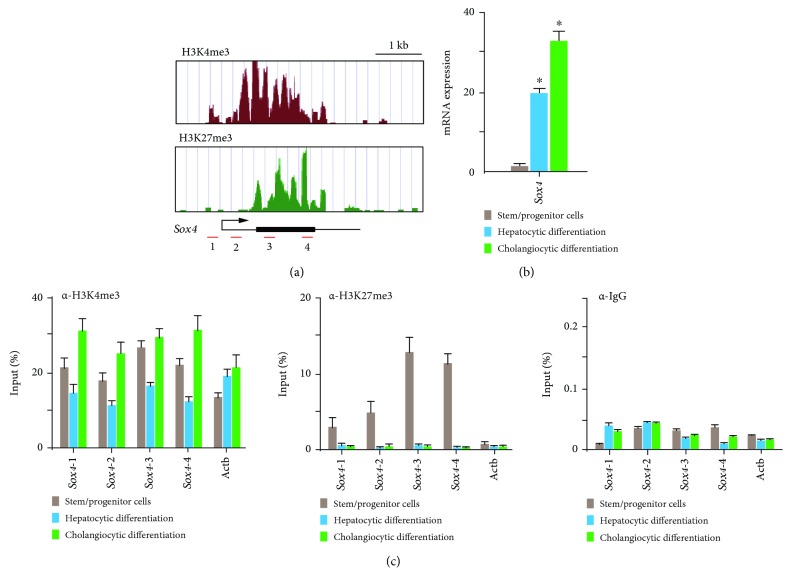
Histone modification status at the Sox4 locus in purified Dlk+ cells and terminally differentiated cells. (a) Signal map of H3K4me3 and H3K27me3 at the Sox4 locus in Dlk+ cells. (b) Real-time RT-PCR analysis of Sox4 in Dlk+ cells and cells differentiated toward hepatocyte and cholangiocyte lineages. ∗Statistically significant (P < 0.05). (c) Quantitative ChIP analyses of the Sox4 locus and Actb control promoter region using anti-H3K4me3 and anti-H3K27me3 antibodies. Percentages of input DNA are shown as mean values for independent triplicate analyses.